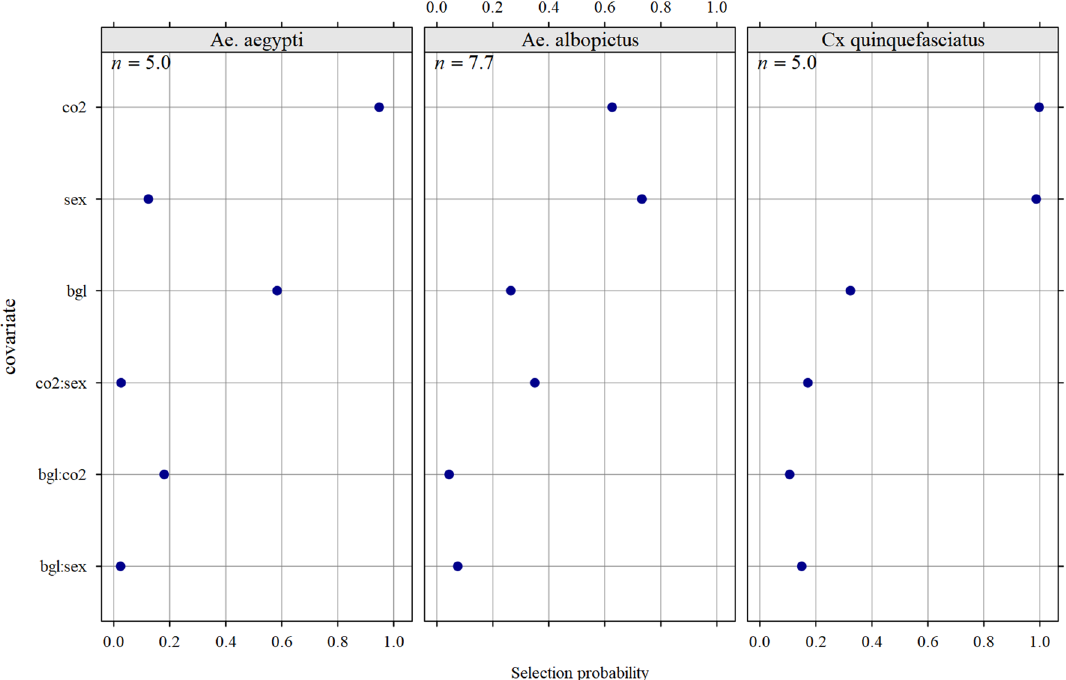
Figure 2. Average probability (200 replicates) for a covariate to be included in the model subset kept for multi hurdle-model averaging of adult mosquito apparent density fitted on data collected in 2020 during a field trial (89 trapping sessions) in La